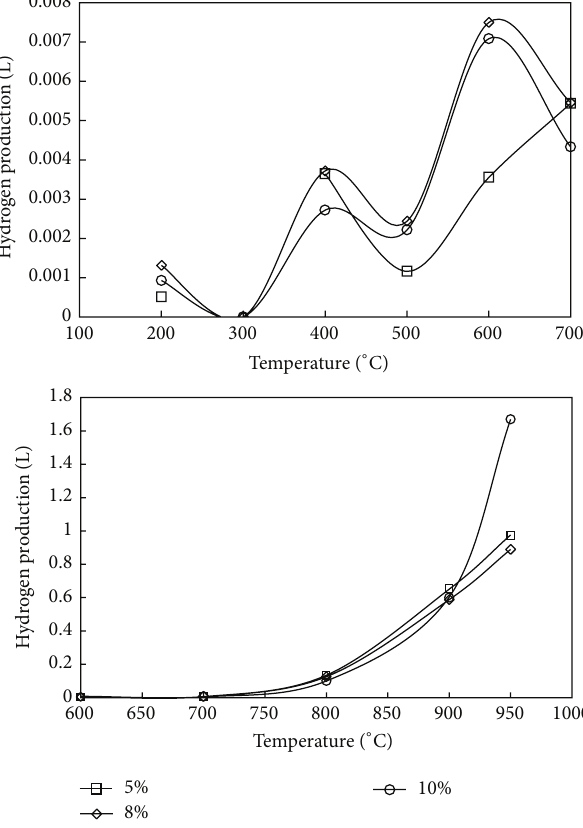
Figure 2: The catalytic activity of different sliver